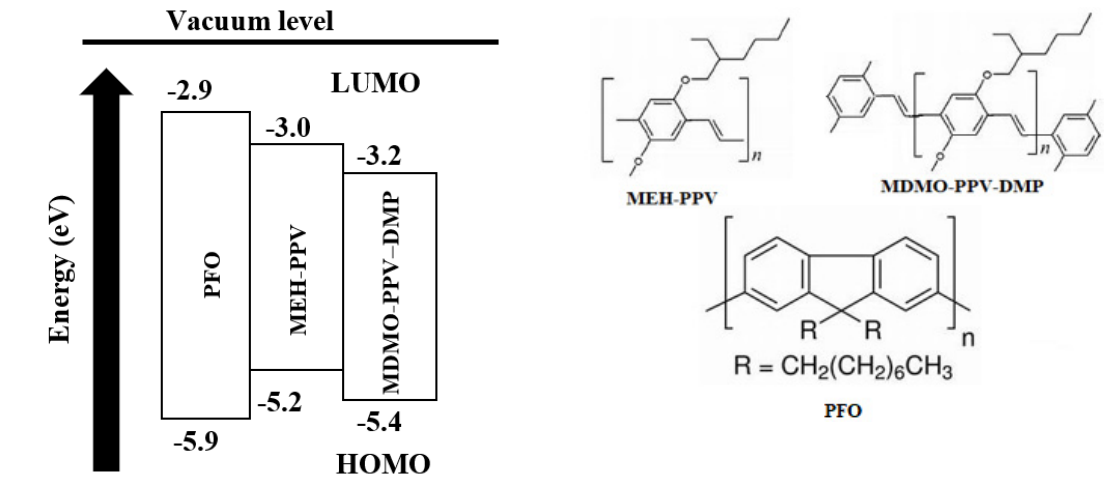
Figure 1. Energy-level diagram of the ternary polymers, and their chemical structures.